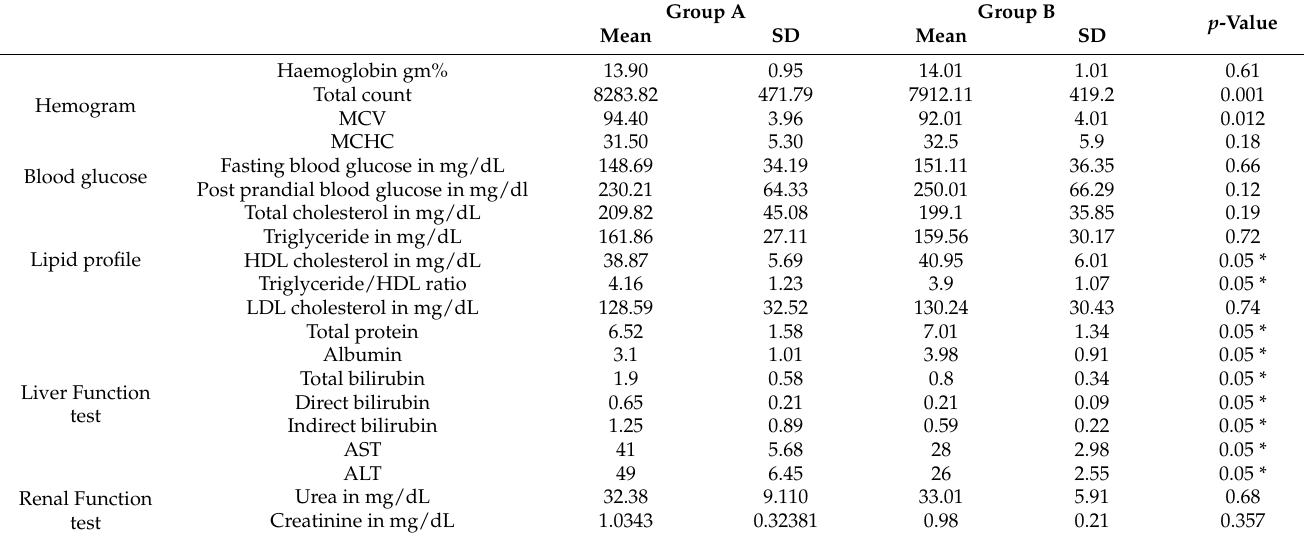
Table 2. Mean levels of the various biochemical parameters in both groups.